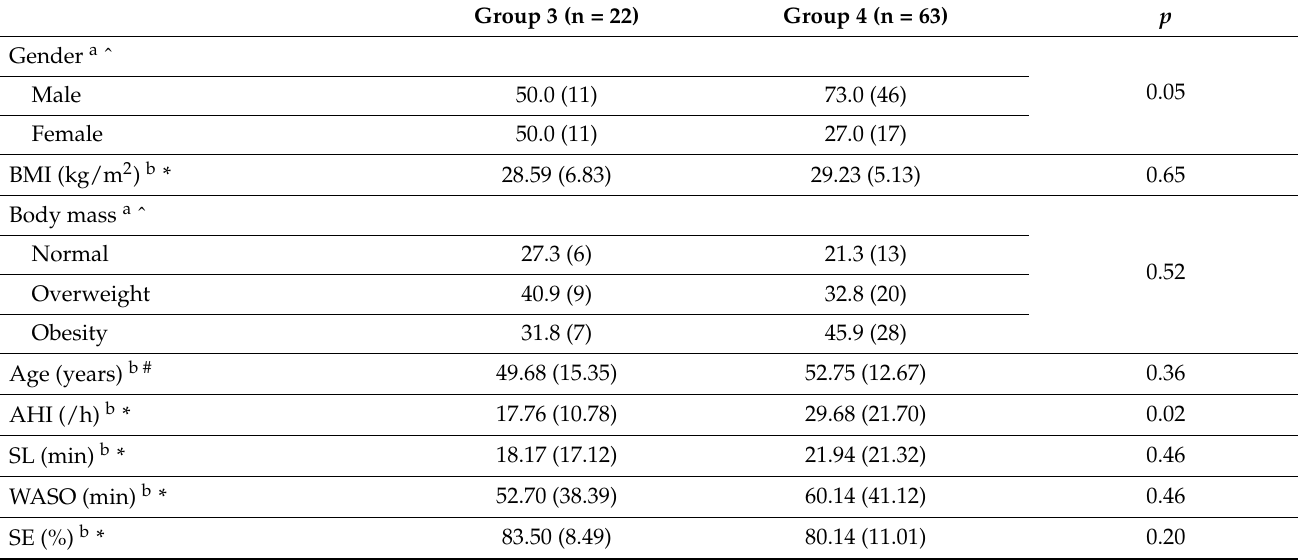
Table 3. Quantitative comparison of the parameters in groups 3 (meeting the criteria of REM-related OSA) and 4 (not meeting the criteria of REM-related OSA—control group). Group 3 (n =